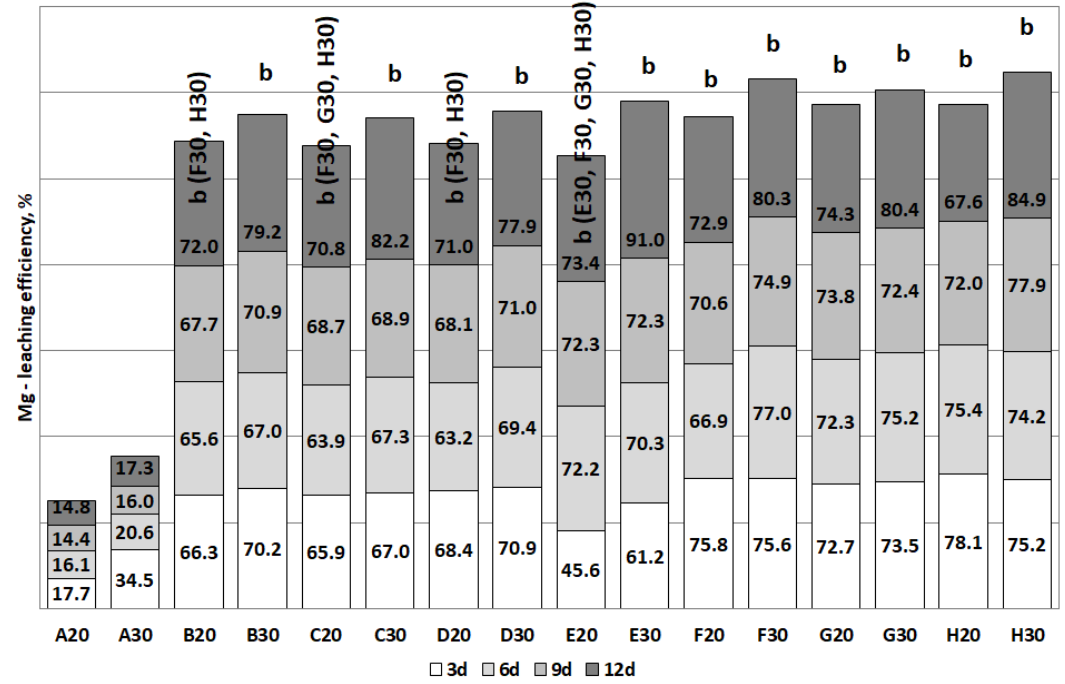
Figure 12. Bioleaching efficiency of Mg during the experiment (Statistical groups a and b ).